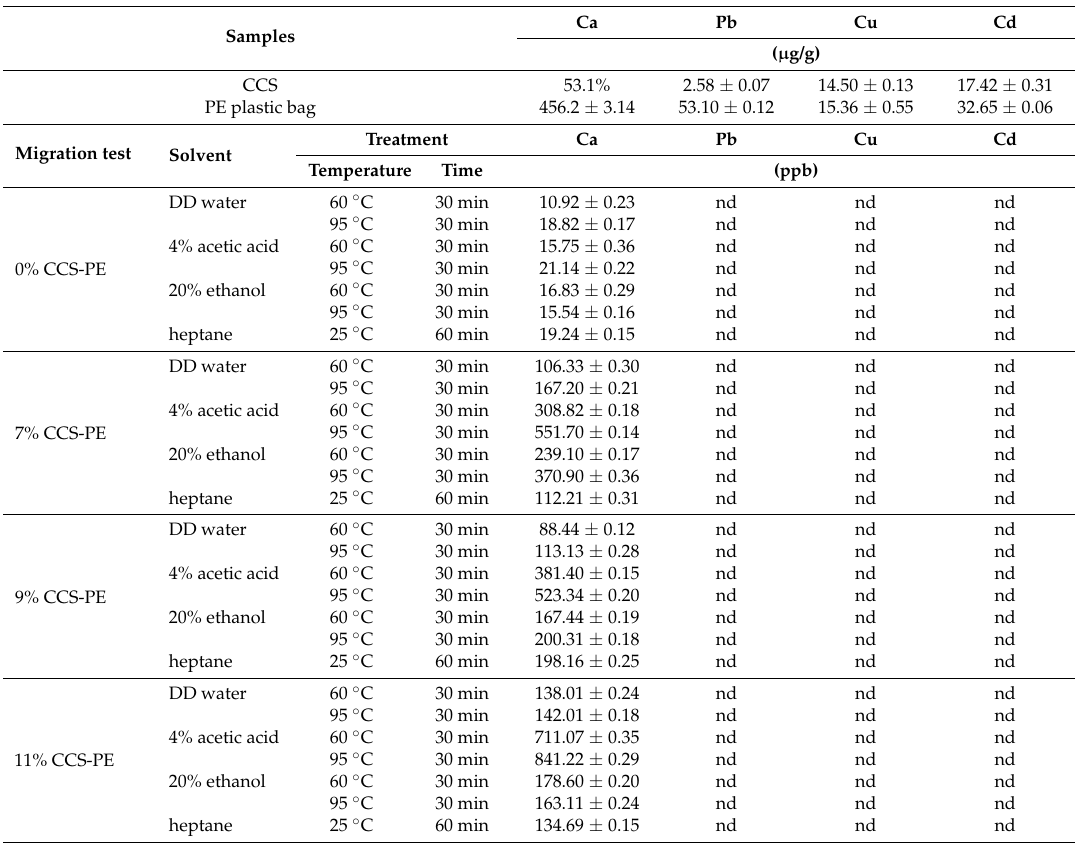
Table 1. The calcium and three heavy metals in calcined waste clam shell (CCS), PE plastic bag (0% CCS-PE) and the migration test from CCS-PE plastic bags with different